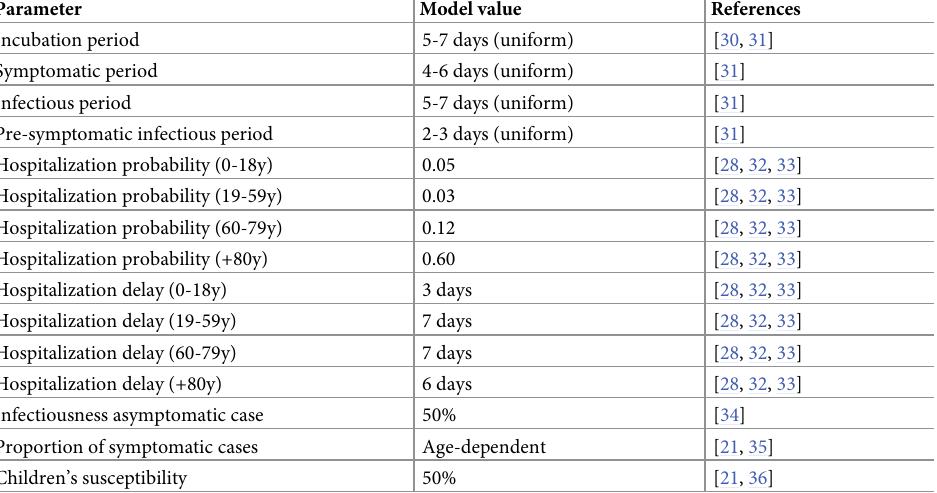
Table 1. Disease characteristics and references. Transition parameters are discretized to the modelling time step of 1 day. The hospitalization probability is conditional upon being symptomatic. A detailed description on the age depen- dent proportion of symptomatic cases can be found in the Supplementary section “Age-specific proportion symptom- atic cases” of the manuscript by Willem et al.